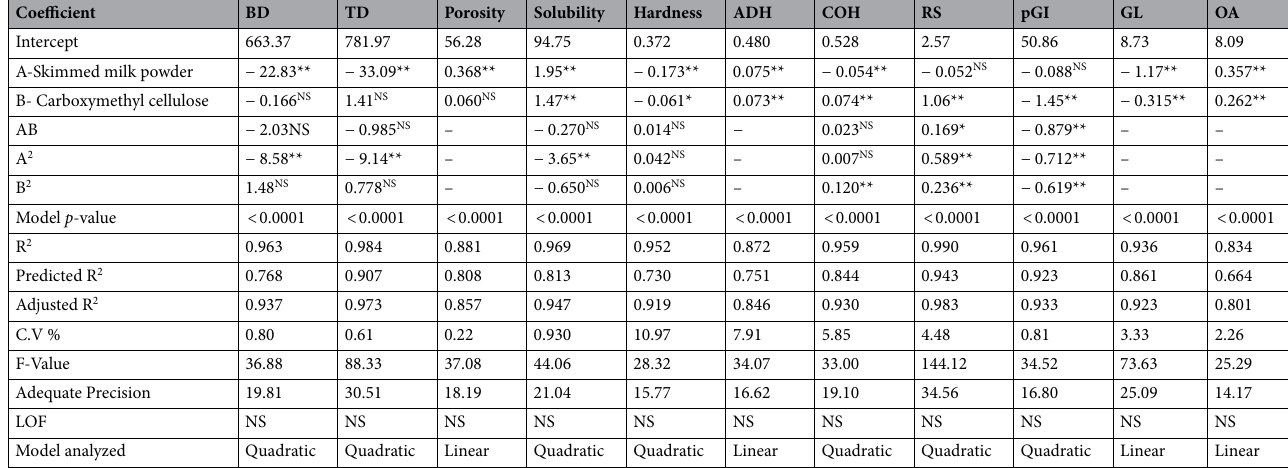
Table 2. Analysis of variance (ANOVA) for the developed regression models. ** Significant at p < 0.01, * Significant at p < 0.05. NS Non-Significant, LOF lack of fit, CV coefficient of variation, LOF lack of fit, BD